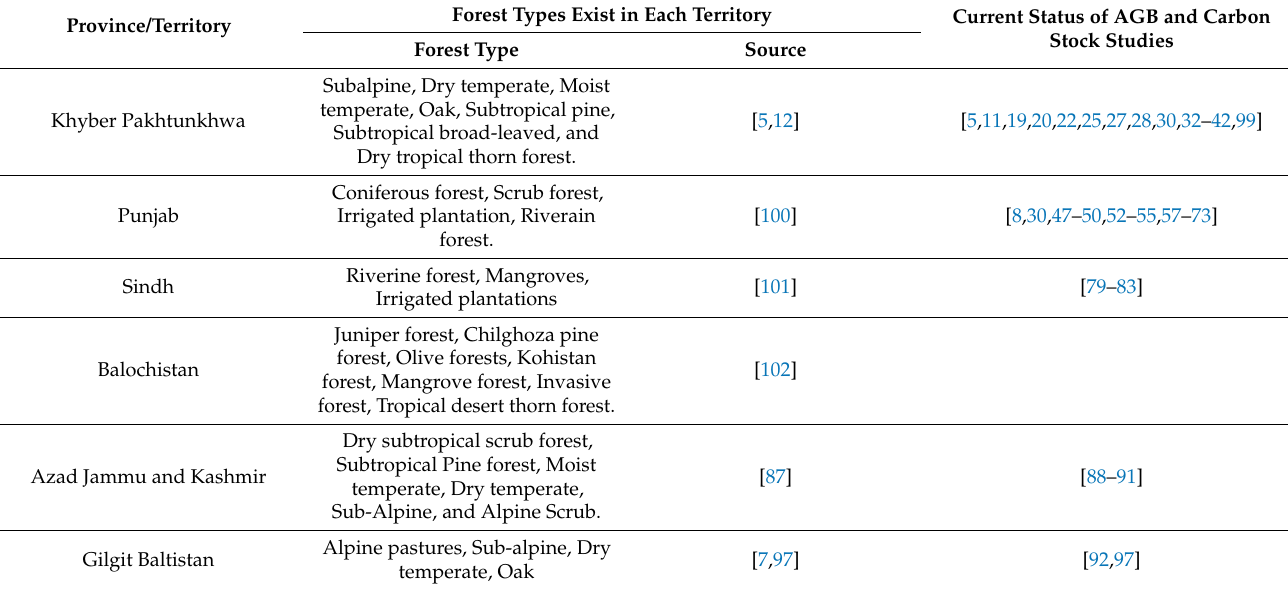
Table 3. Current status of each territory with respect to above-ground biomass (AGB) and carbon stock studies. Forest Types Exist in Each Territory Current Status of AGB and Carbon Province/Territory